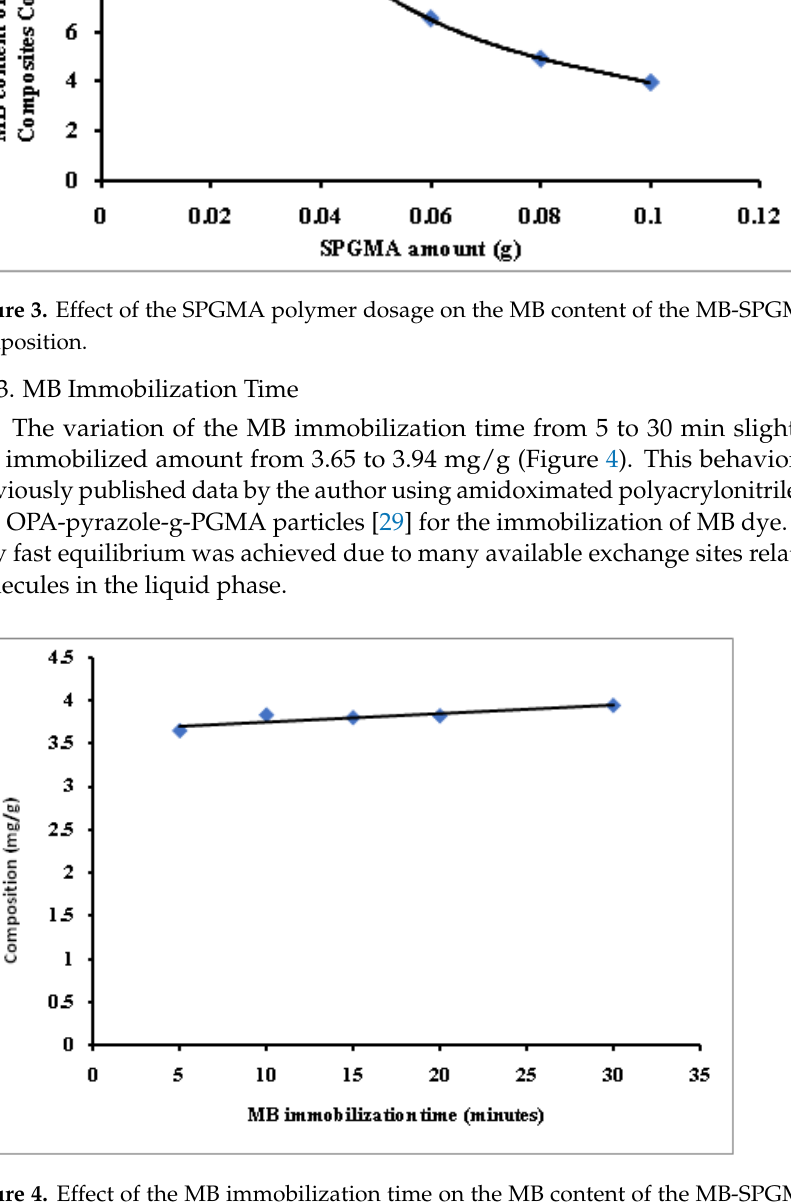
Figure 4. Effect of the MB immobilization time on the MB content of the MB-SPGMA composites composition.